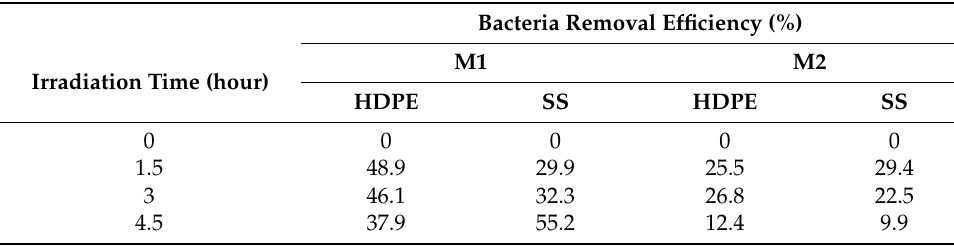
Table 3. Bacteria removal efficiencies (%) by P25 TiO 2 immobilized by two methods (M1, M2) on the study materials (HDPE, SS) (n = 3). Initial bacteria concentration Co = 3.9 Log.